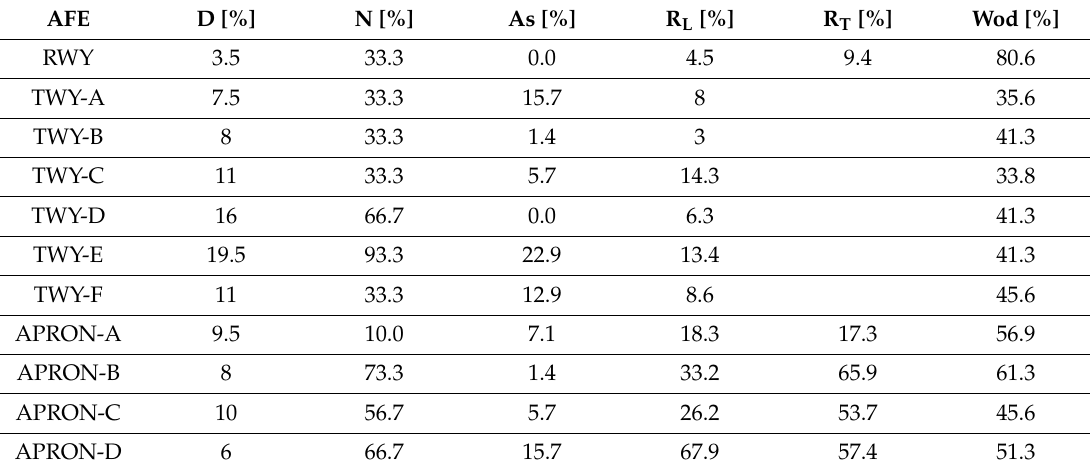
Table 4. Indicators of input data parameters for analysis by the APCI method.